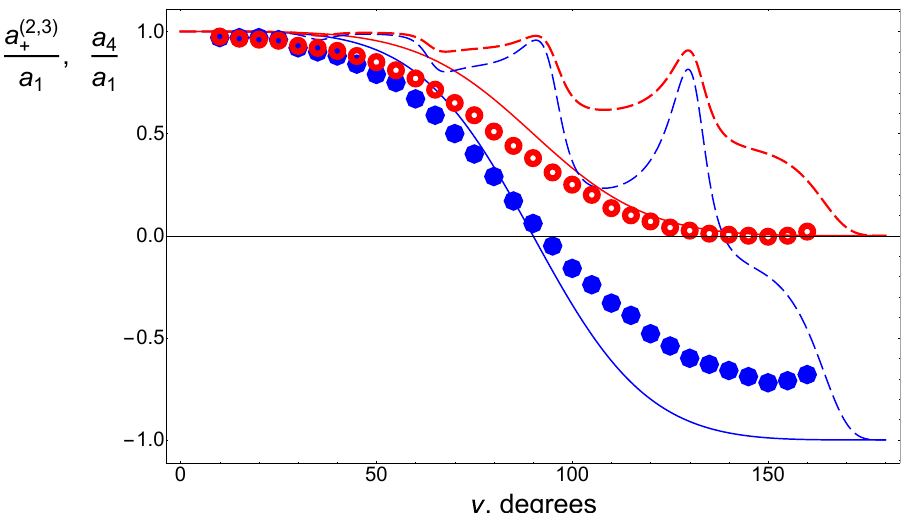
( 2,3 ) ( γ )/ a ( γ ) and a ( γ )/ a ( γ ) as functions of scattering angle γ for sea water [49] Figure 3. Ratios a + 1 4 1 (symbols ○ and ● , respectively). For comparison, the Rayleigh values (solid curves) and the results of calculations with code [60] for aqueous suspension of polystyrene spheres (diameter d = 0.993 µ m, wavelength λ = 633 nm, dashed curves) are also